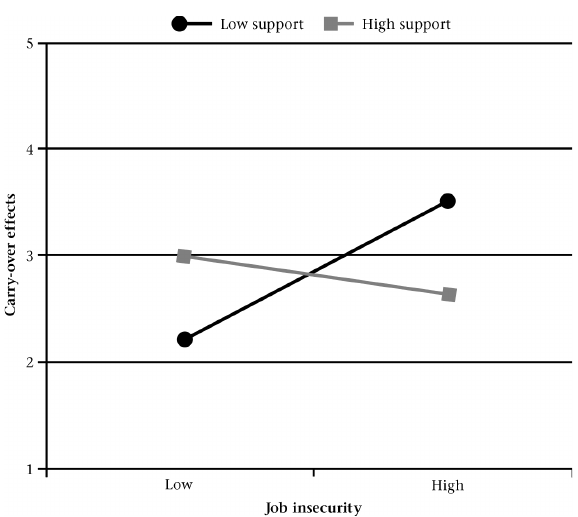
Figure 3: Interaction between job insecurity and work-based support on carry-over